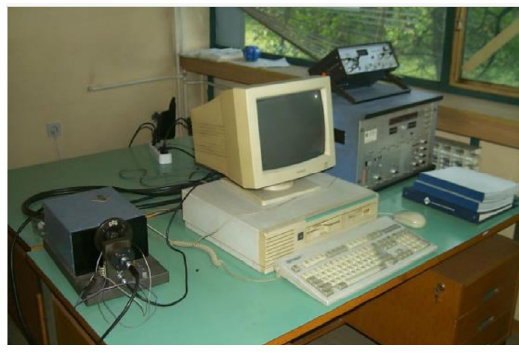
Figure 3. CRACKTRONIC pulsator Tests are performed with specimens from parent metal, weld metal, and heat-affected-zone of HSLA welded joint, at room temperature. Crack growth is monitored by measuring potential drop by strain gauge RUMUL RMF A-5 [9], measuring 5 mm length, located on the specimen face surface, Fig. 4.